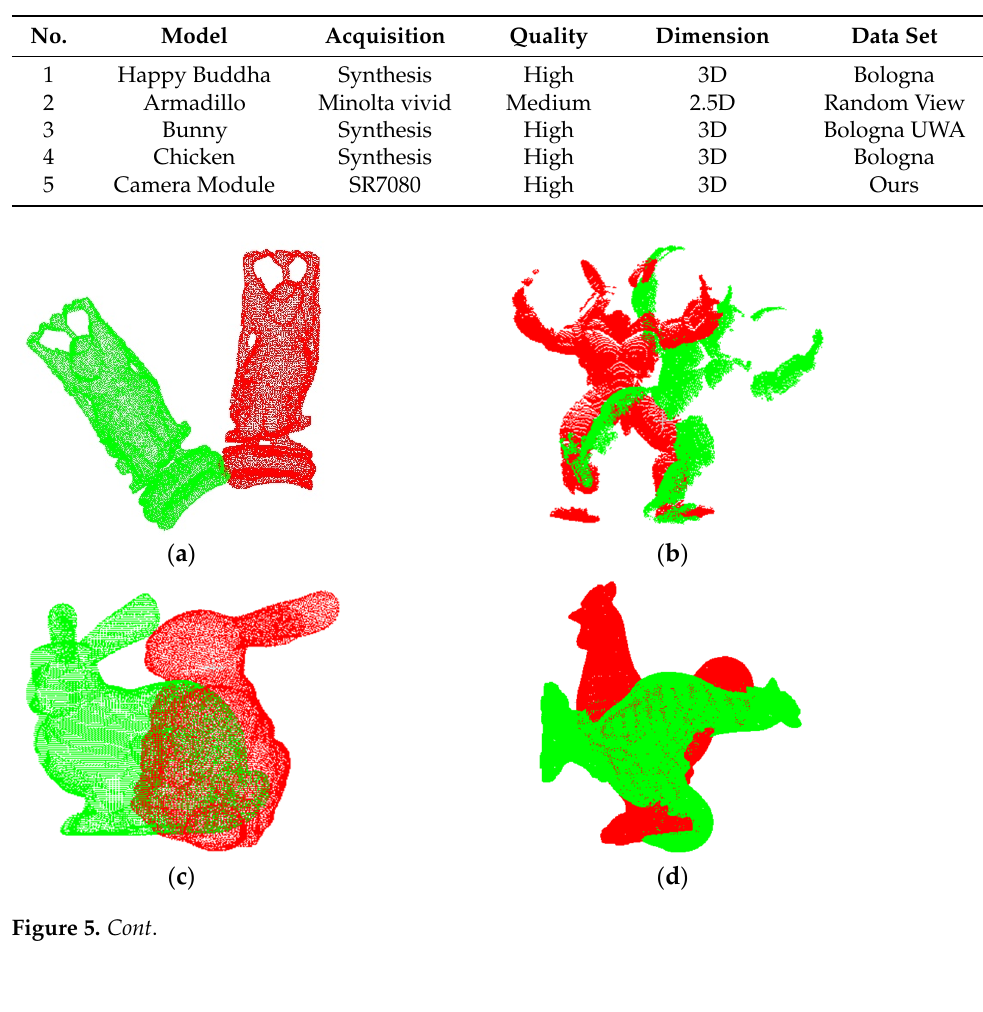
Table 1. Data used in the experiment.